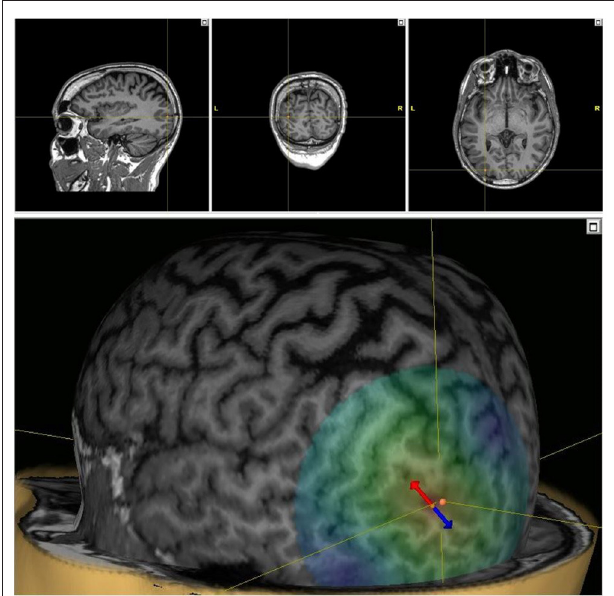
FIGURE 2 | TMS targeting. Stereotactic TMS targeting using the patient’s MRI in 3 planes (top) and 3D model (bottom). The dipole of the TMS pulses is indicated, with the arrows indicating the direction of the induced electric field (red cathodal, blue anodal).